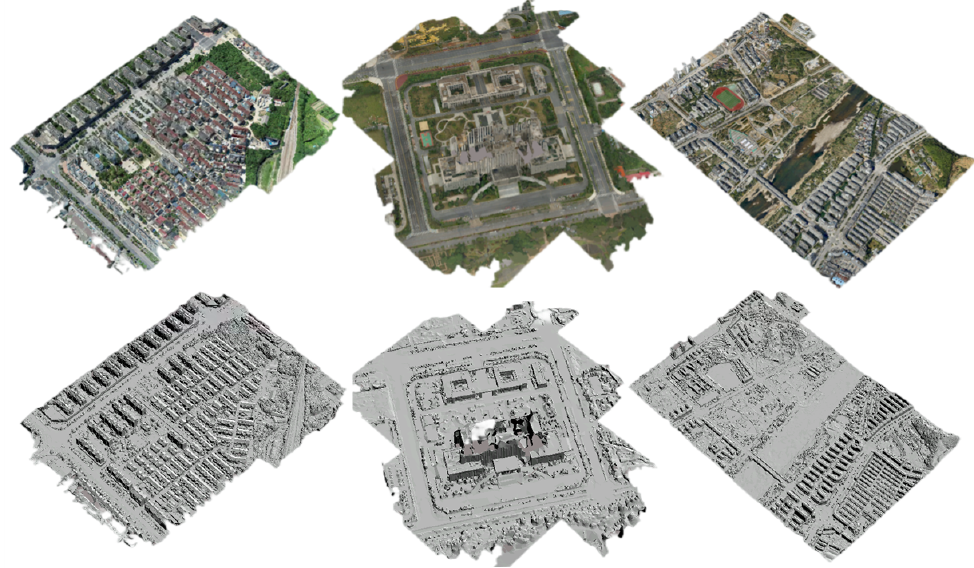
Figure 4. Three datasets used in experiments. The datasets from left to right are TJH-0078, TJH-008812, and